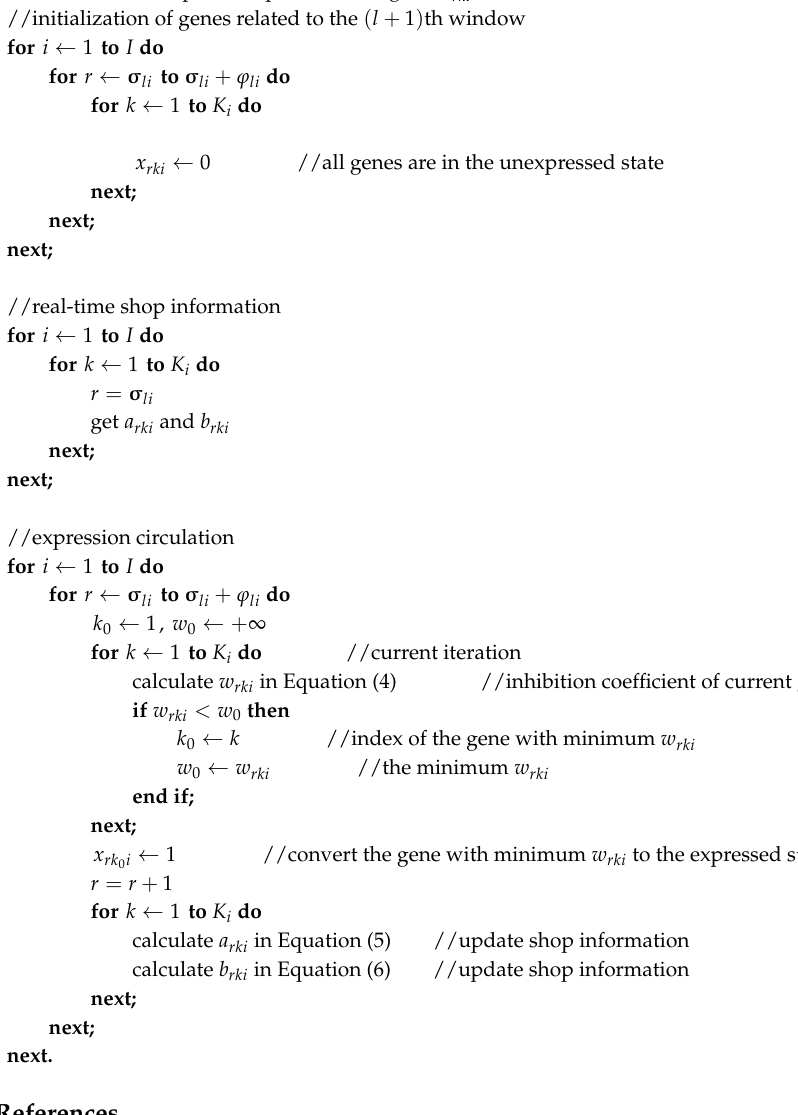
Pseudo codes of expression procedure of gene π rki : //initialization of genes related to the ( l + 1 ) th